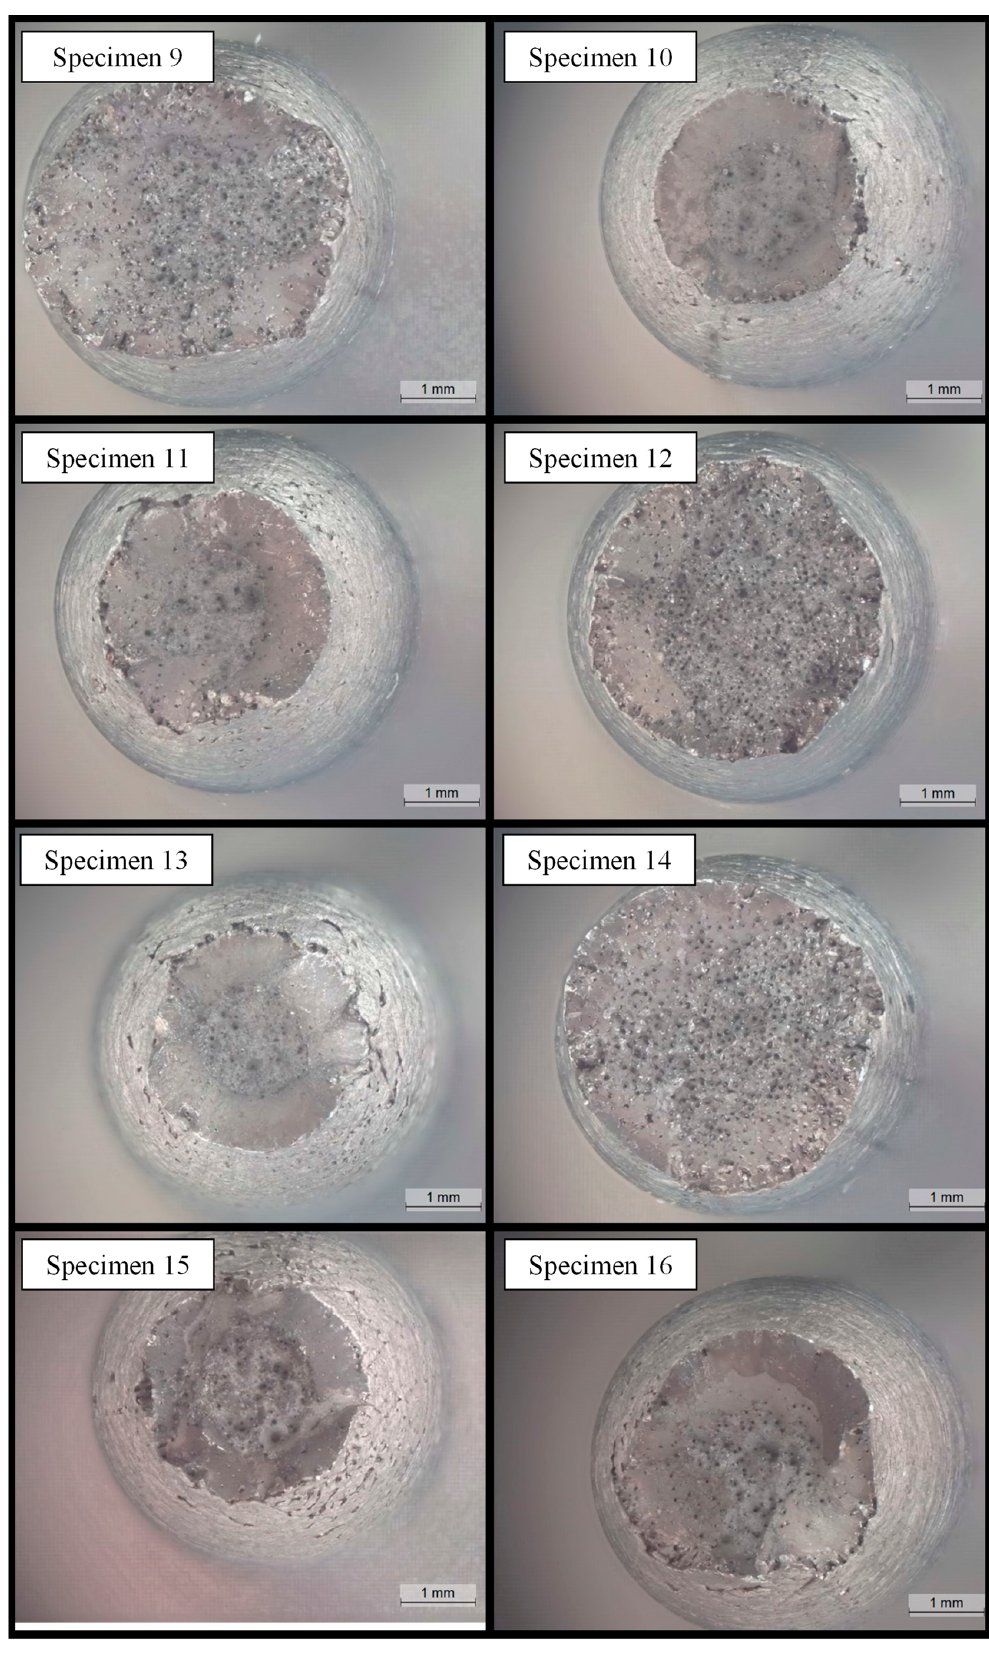
Figure 4. Optical micrographs of specimens 9 to 16.